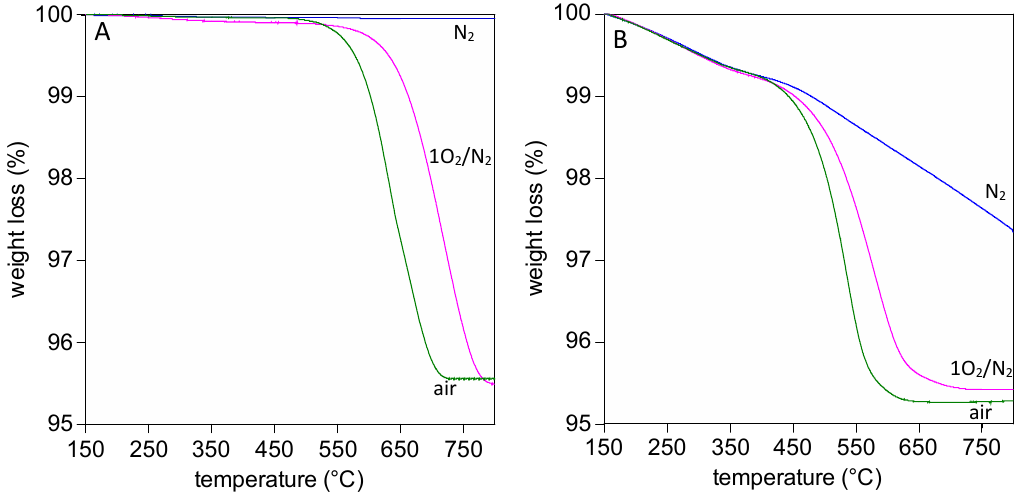
Figure 4. Weight loss profiles obtained from TGA analysis of bare soot ( A ) and CZL ( B ) under different atmospheres (air, 1% O 2 in N 2 and N 2 ).